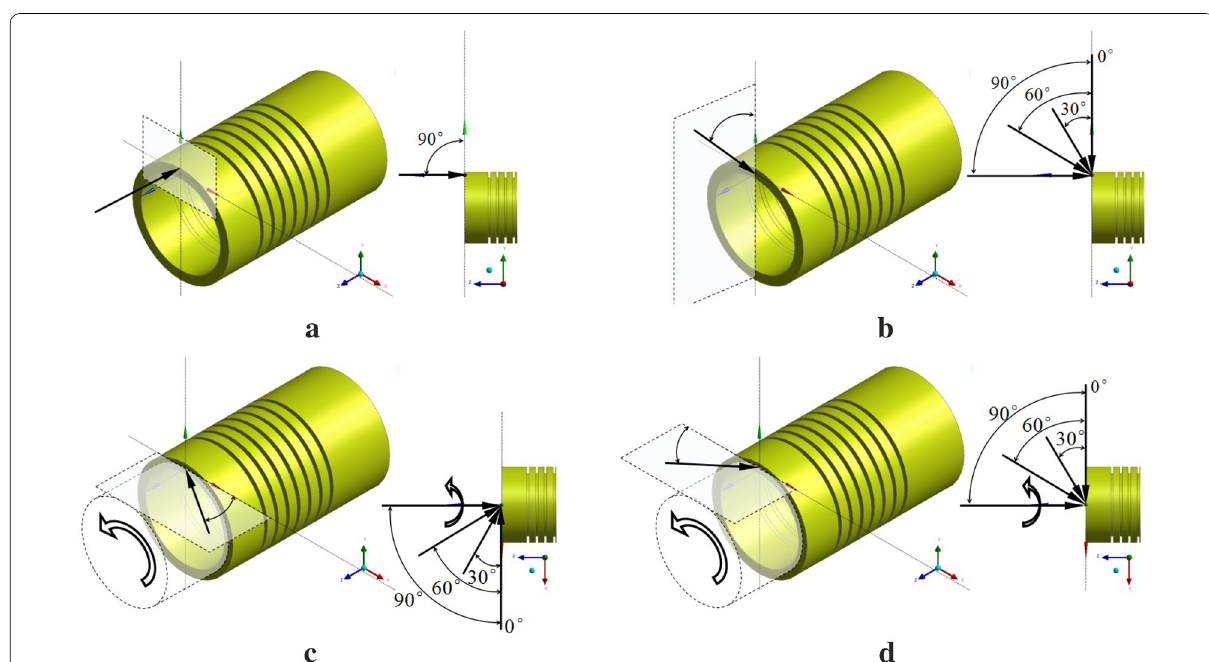
Figure 3 Four types of pre-swirls: a axial pre-swirl; b radial pre-swirl; c circumferential positive pre-swirl; d circumferential negative